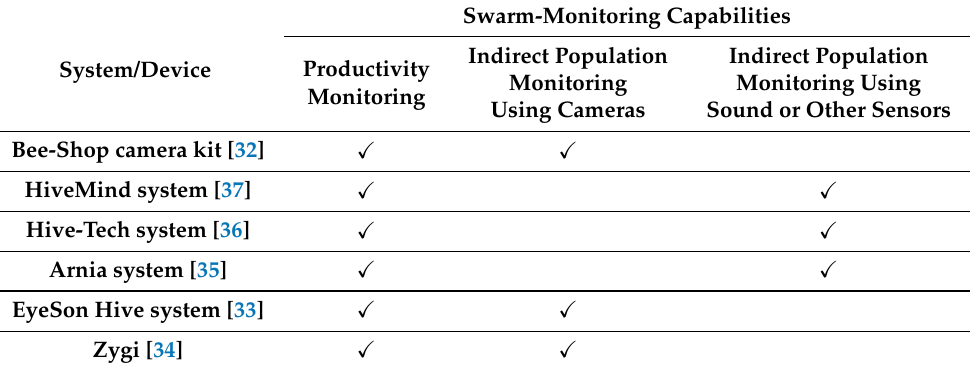
Table 1. Existing bee-swarming-monitoring